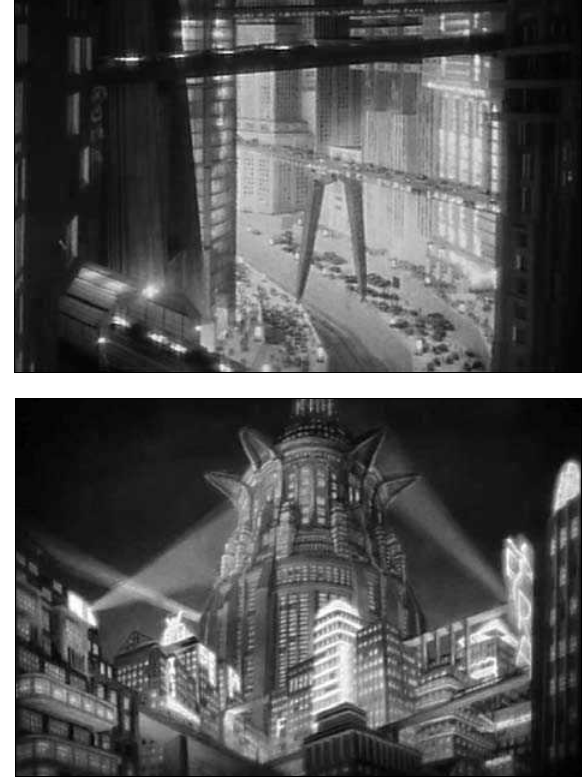
6 pav. kadrai iš kino filmo „Metropolis“, 1927 m. Fig. 6. Frames from film “Metropolis”,